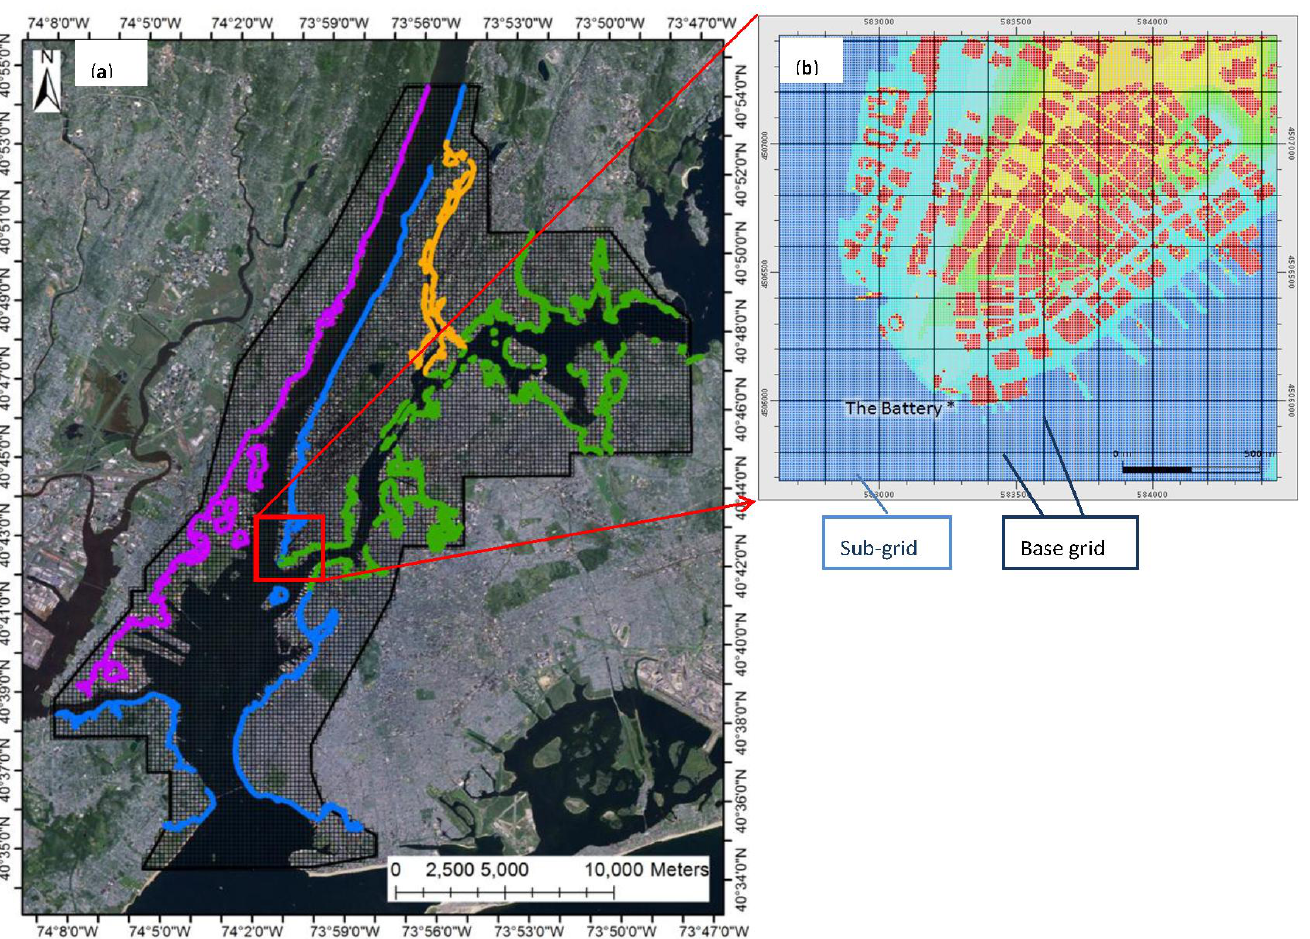
Figure 3. ( a ) The sub-grid inundation modeling domain in New York City covering the Hudson River up to Yonkers, the Harlem River, part of the Long Island Sound up to King’s Point and each of their tributaries, shown in base grids. ( b ) The sub-grid 5 m by 5 m embedded in the 200 m × 200 m resolution base grid over the shaded area in lower Manhattan (right) including ―The Battery‖. The LIDAR data are directly imported into the uniform square sub-grids to resolve the building and the